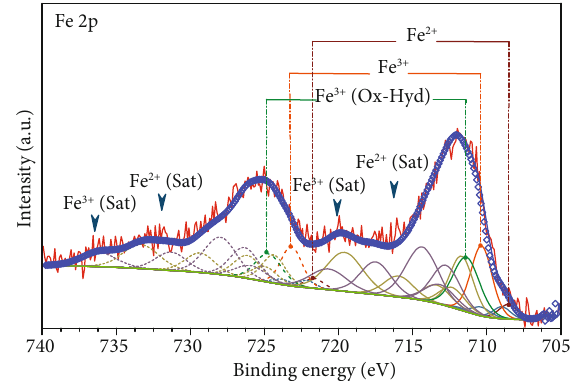
Figure 4: XPS spectrum at core level of MNZ/Fe in the Fe 2p region. Table 2: XPS spectrum parameters at core level of Fe 2p magnetite.